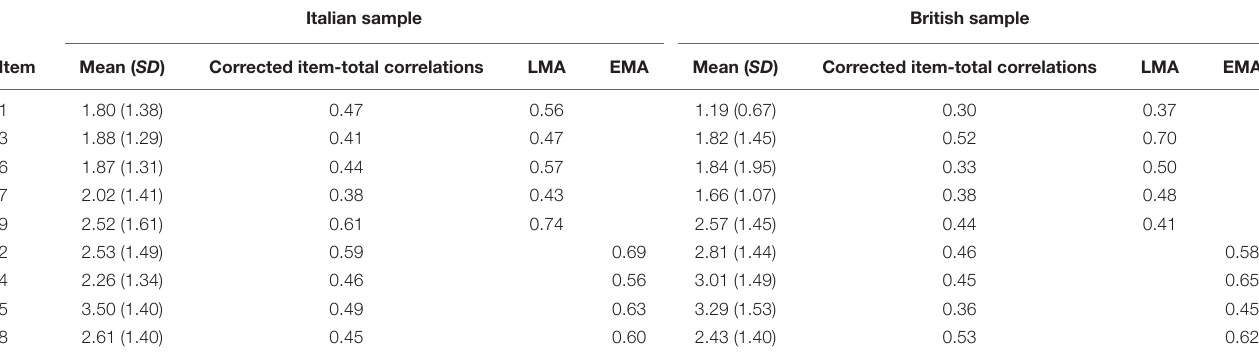
TABLE 4 | Means, standard deviations (SDs), item- total correlation for each item and factor loadings of the EES-AMAS for each sample. Italian sample British